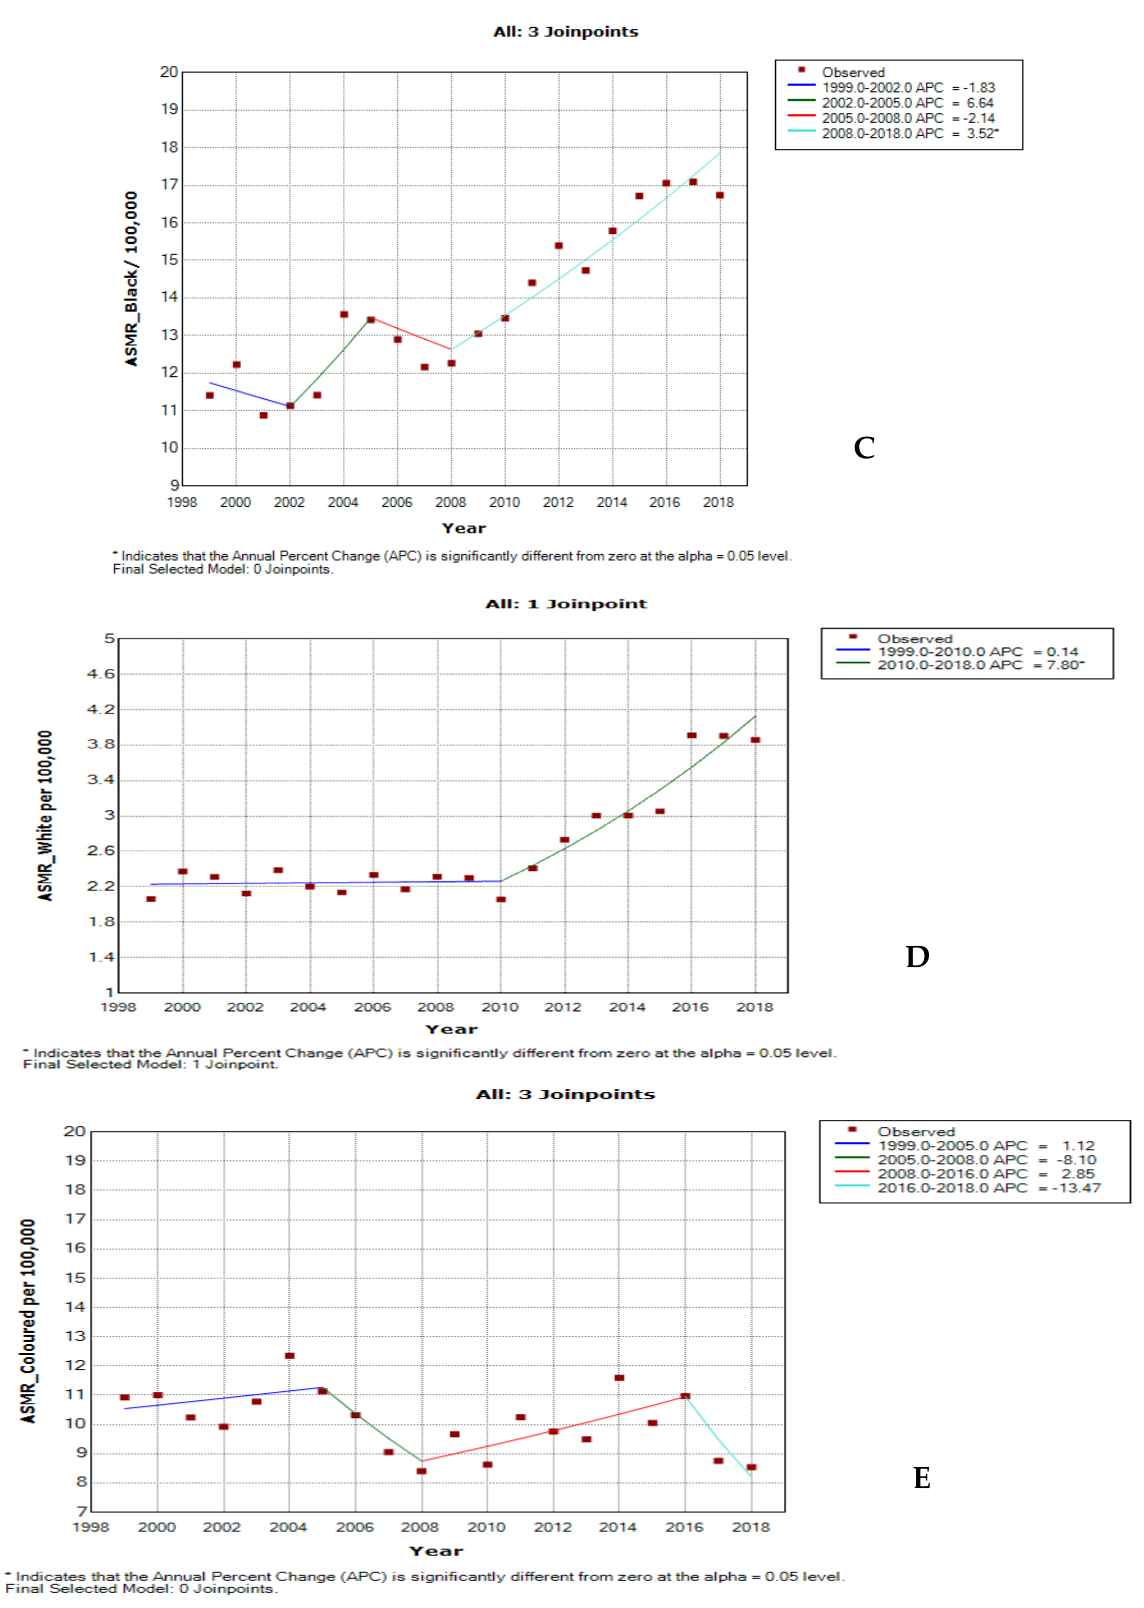
Figure 2. Joinpoint regression trends of the annual age-standardised mortality rate for cervical cancer in South Africa (1999–2018) for: ( A ) overall; ( B ) Indians/Asians; ( C ) Blacks; ( D ) Whites; and ( E ) Coloured ethnic groups.